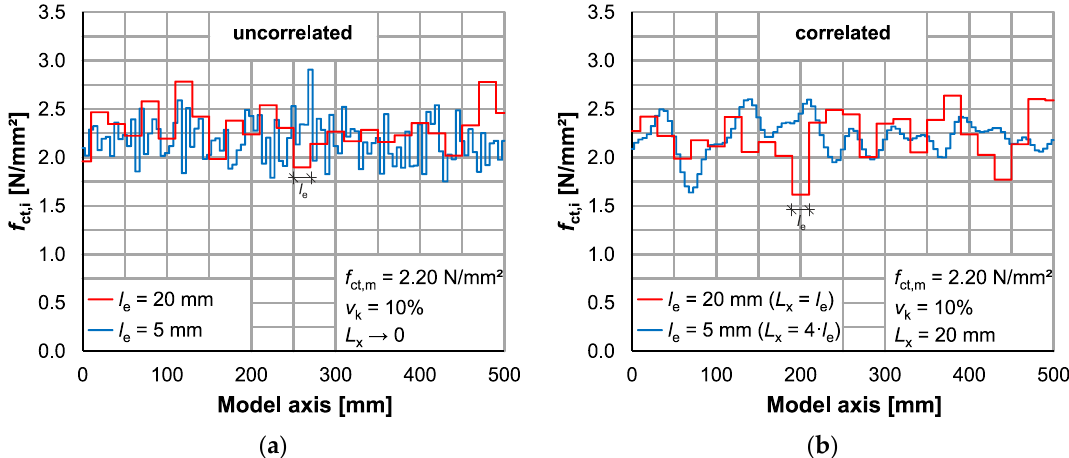
Figure 9. Element length l e vs. correlation length L x for ( a ) uncorrelated and ( b ) correlated distributions along the model axis.